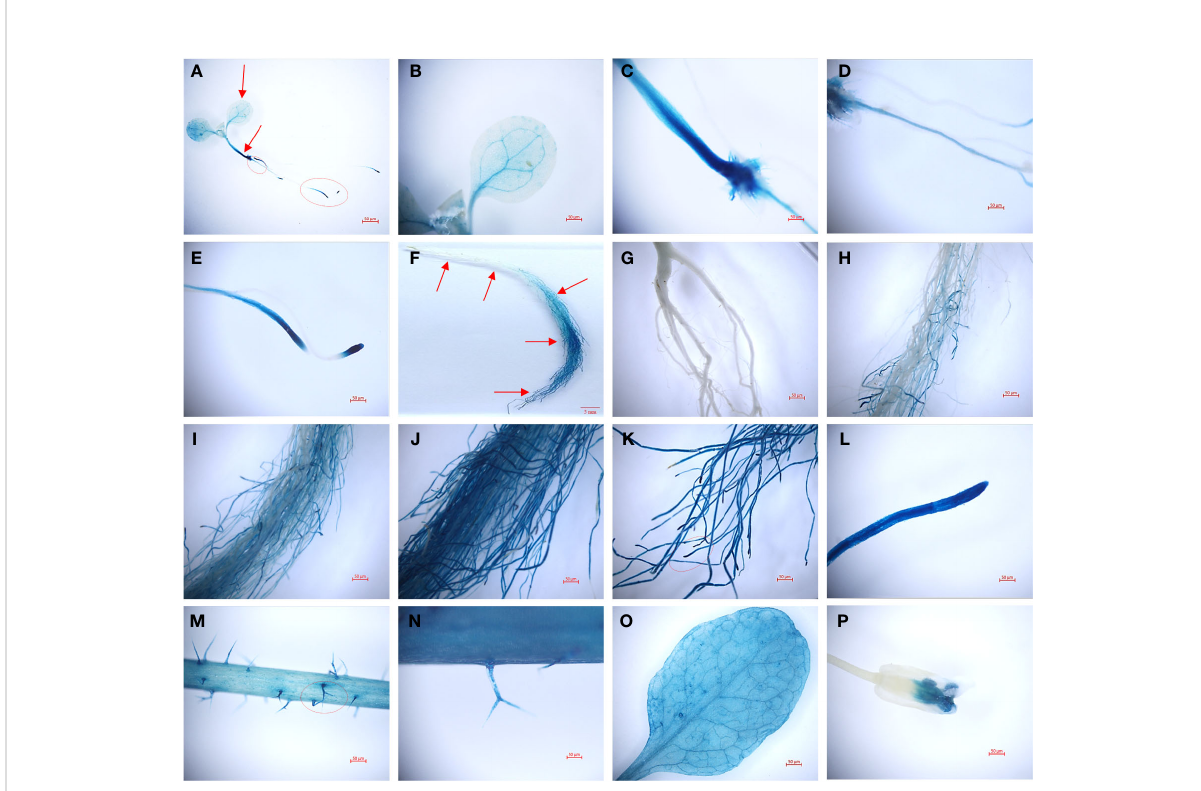
FIGURE 4 GUS histochemical staining with a TaHAK13 promoter in transgenic Arabidopsis thaliana . (A-E) Zoomed out image of a transgenic Arabidopsis seedling (A) and its leaf (B) , stem (C) , taproot (D) , and lateral root apex (E) . (F-P) Zoomed out image of a root (F) and enlarged images of the indicated root positions (marked with red arrows) (G-L) in mature transgenic Arabidopsis plants; also pictured are the stem (M) , stem surface (N) , leaf (O) , and fl ower (P)